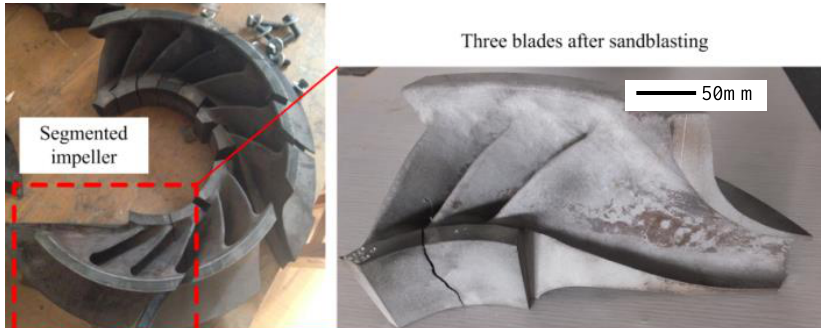
Figure 6. Macro-morphology of impeller and blades.